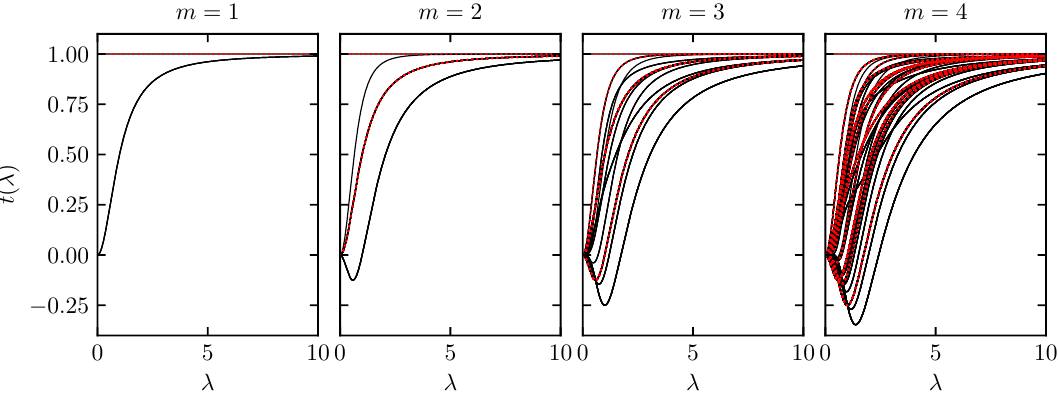
( λ ) of the transfer matrices T ( λ ) at different sizes. Black Figure 1: Eigenvalues t m m lines denote the eigenspectrum at fixed m , dotted red lines are overlaid on eigenvalues obtained from smaller transfer matrices, highlighting the nesting of the